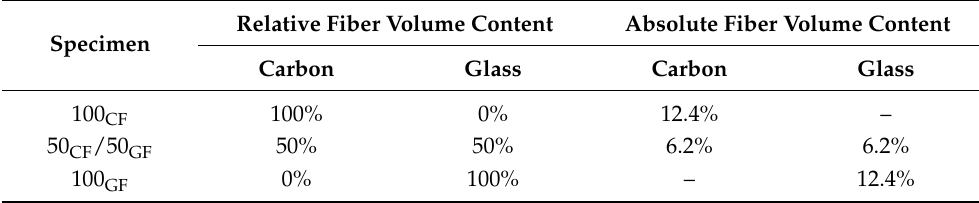
Figure 5. Specimens with tabs made of glass fiber-reinforced plastic: ( a ) hybrid tensile specimen, ( b ) tensile specimen with glass fiber reinforcement, and ( c ) tensile specimen with carbon fiber reinforcement. Table 3. Relative and absolute fiber volume contents of manufactured hybrid and non-hybrid